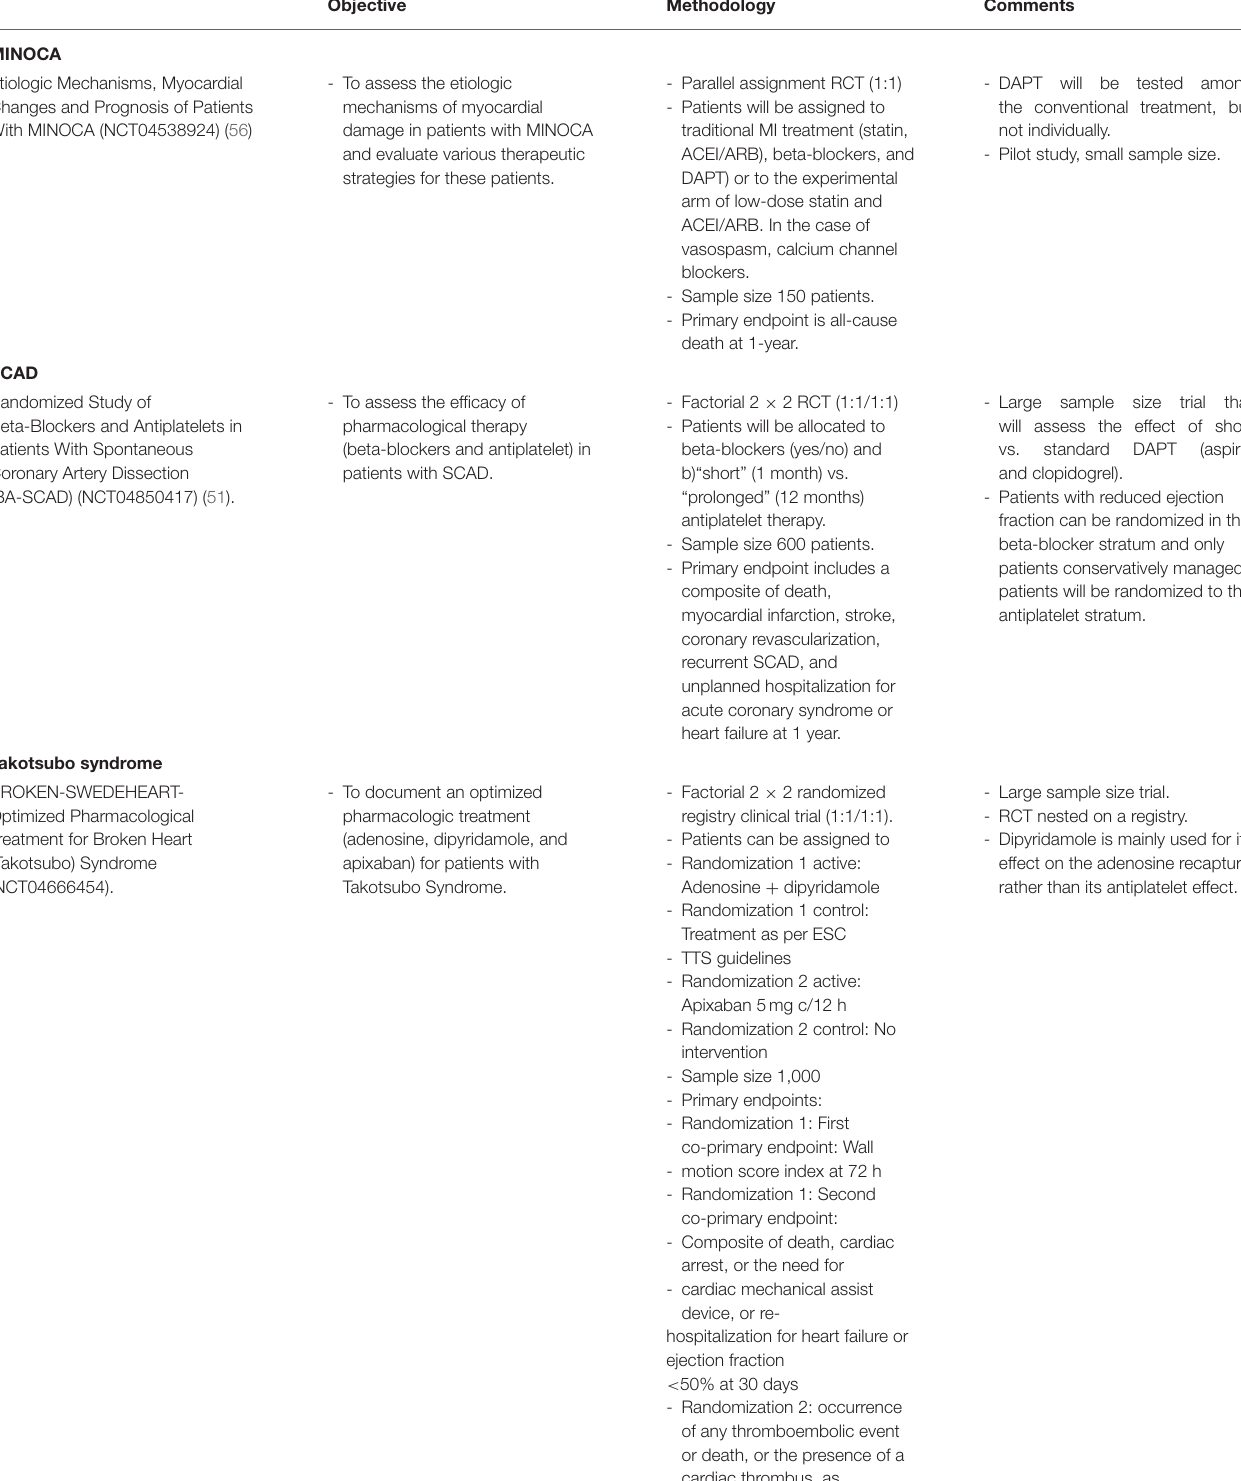
TABLE 4 | Ongoing clinical trials assessing the role of antiplatelet therapy in